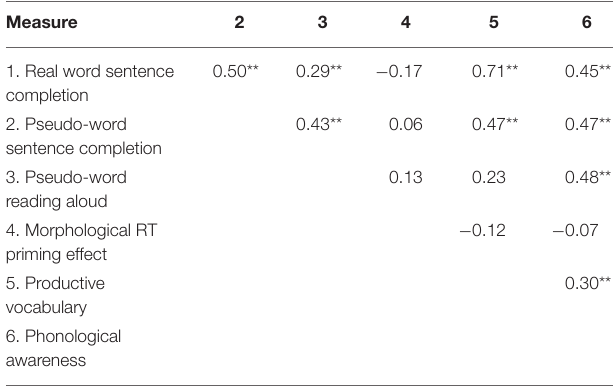
TABLE 4 | Correlations among morphological knowledge, vocabulary, and phonological awareness tasks for the entire sample ( N = 112)*.